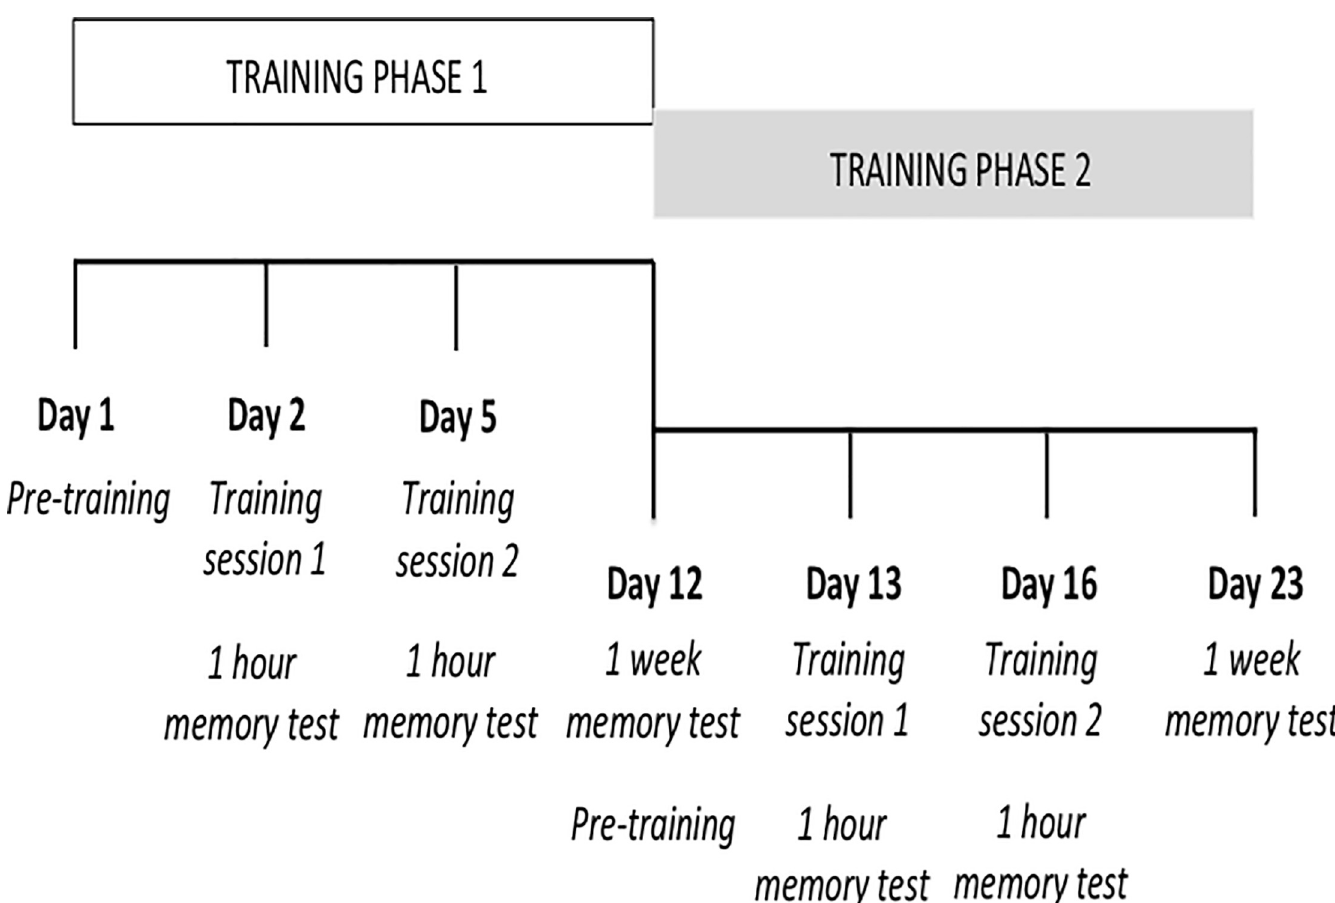
Fig 2. Sequential progression (from left to right) of the two phases of the study. The memory task was performed one hour after each of the two training sessions and a week after the last training session of each phase (see Fig 2). The memory task consisted of two trials, one with each trained pill-time of day association, identical to that used during the training sessions except that outcomes were not administered at all. That is, as it is depicted in Fig 1B, participants first saw the picture of a pill and, after a short delay (500 ms), they had to choose, by touching the screen, the picture of the time of day associated with the pill. After a response was made, the screen remained blank for 2500 ms, and then the next trial